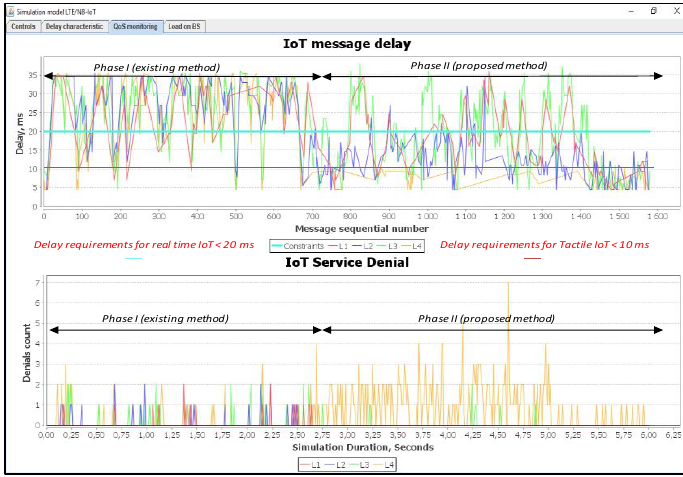
Figure 17. Delay and service denials for service requests from IoT devices (average load of IoT controller ρ = 50%).